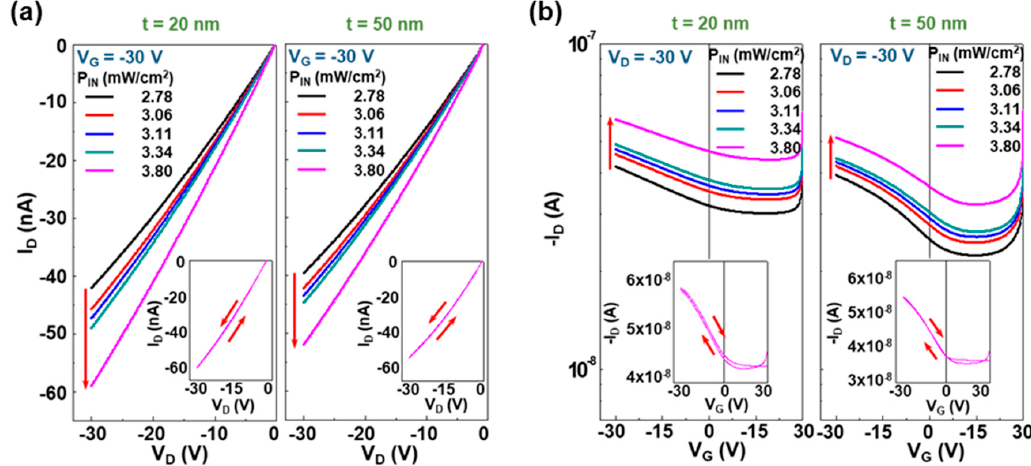
Figure 5. ( a ) Output and ( b ) transfer curves for the NIR-OPTRs with the CDS structures under illumination with the NIR light (905 nm). The incident NIR light intensity (P IN ) varied between 2.8 and 3.8 mW/cm 2 . The inset graphs in (a) show the representative output curves (swept between V D = 0 V and V D = − 30 V) at V G = − 30 V and P IN = 3.80 mW/cm 2 , while those in ( b ) show the representative transfer curves (swept between V G = 0 V and V G = − 30 V) at V D = − 30 V and P IN = 3.80 mW/cm 2 .